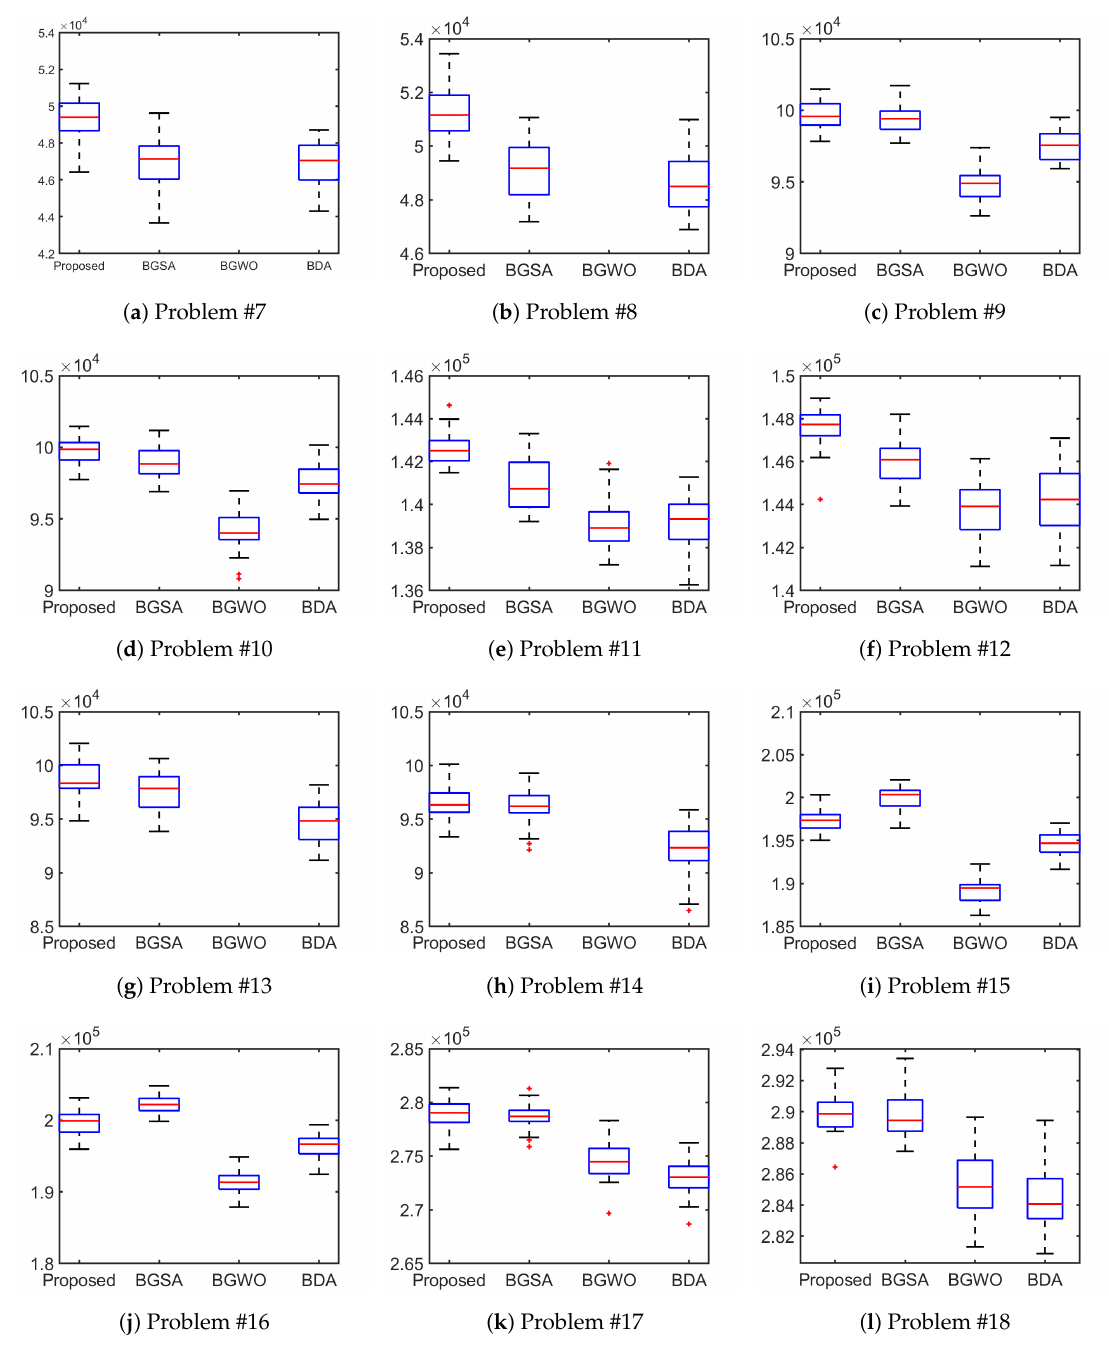
Figure 3. Box plot obtained for the knapsack problem using the proposed XOR BGSA vs. three other algorithms namely: BGSA [16], BGWO [18] and BDA [19]. Knapsack optimization problems 7 to